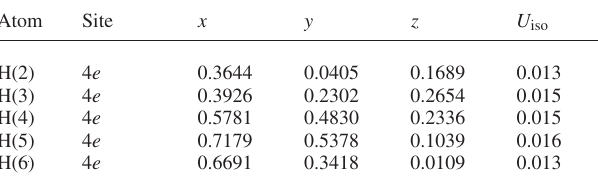
Table 2. Atomic coordinates and displacement parameters (in Å 2 )